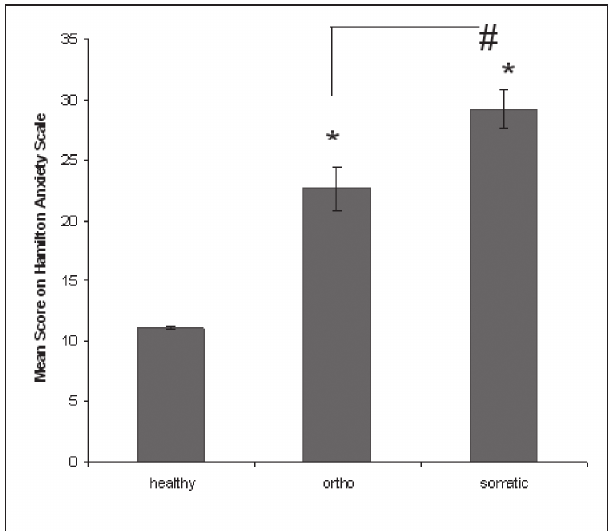
Fig. 2. HAS scores (mean (standard error)) for the healthy subjects (healthy, N=50), orthopaedic patients (ortho, N=41) and patients with multiple somatic complaints (somatic, N=25) (*p<0.05 v. healthy subjects (controls), #p<0.05 v. orthopaedic patients). ANOVA showed that the mean HAS scores for the orthopaedic patients as well as for the patients with multiple somatic complaints were significantly higher than the mean score for the